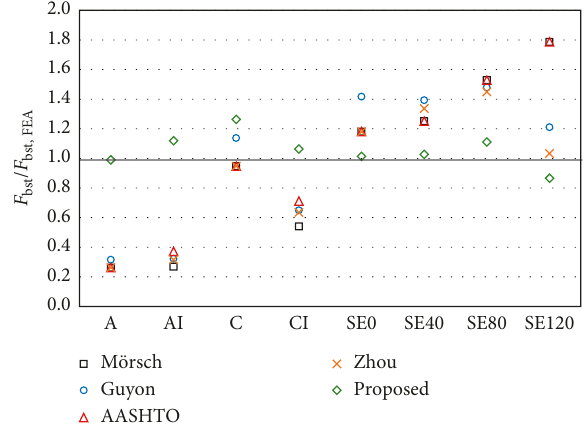
Figure 14: Evaluation of the proposed bursting force equation.